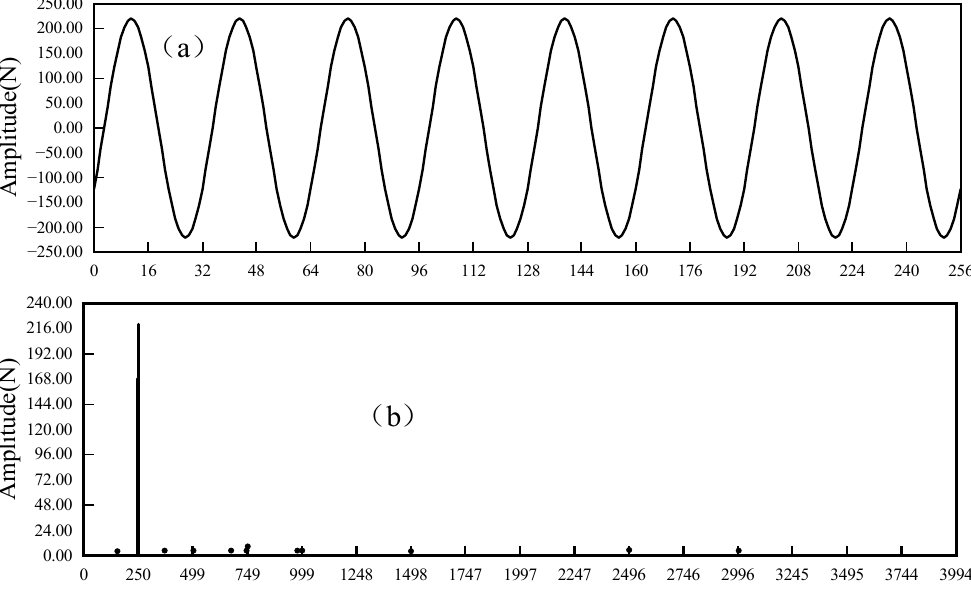
Figure 5. Time response and frequency spectral for rotating force signals.